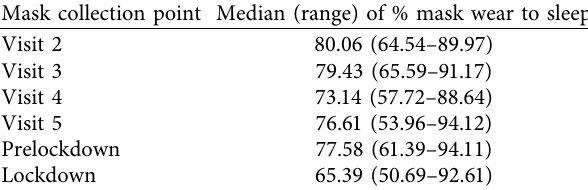
Table 2: Median and range of percentage compliance for the masks returned at each visit based on reported sleep hours and measured mask wear. Mask collection point Median (range) of % mask wear to